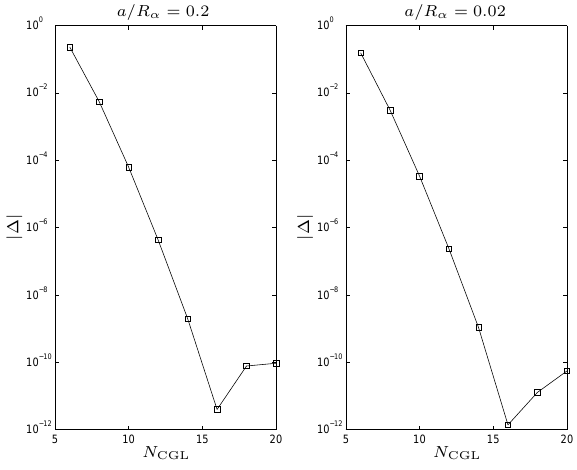
Figure 3: Convergence analysis. Fundamental frequency λ = ω ( a 2 / h ) √︀ ρ / E 2 of a moderately thick ( a / h = 10 ) square simply sup- ported [0/90/0] spherical panel with a / R α = 0.2 and a / R α = 0.02 . Values computed using ED2